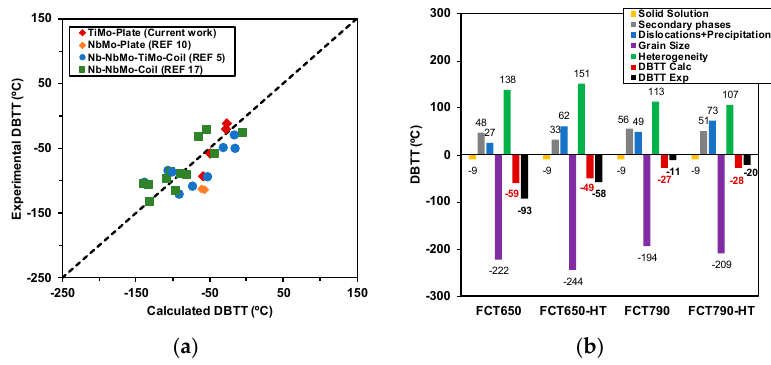
Figure 18. ( a ) Comparison between experimental and calculated DBTT values predicted by Equation (2). The data reported by Isasti et al. [17] and Larzabal et al. [5,10] have been included in the graph. ( b ) Estimated contributions (solid solution, secondary phases, dislocation + precipitation, grain size and heterogeneity) to the DBTT for every condition and comparison with experimental values.